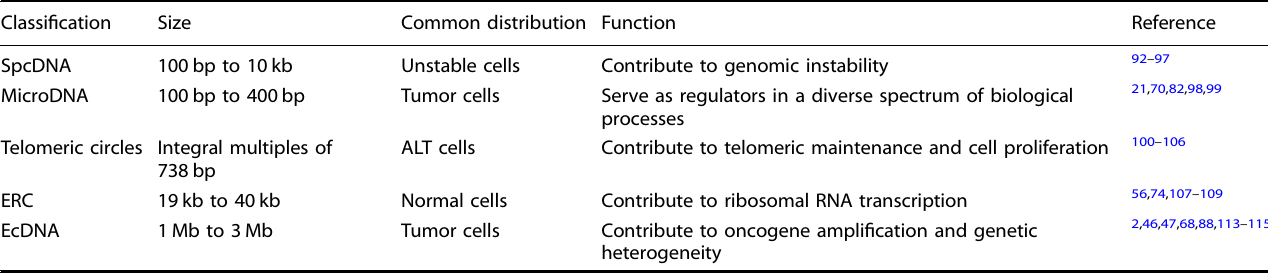
Table 1. The unique characteristics and functions of different types of